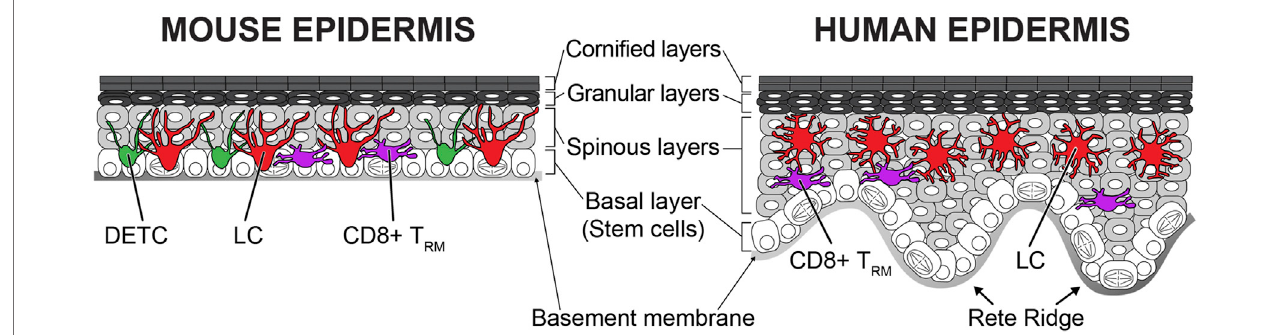
FIGURE1| Structure andcellularcomponentsofmouseandhumanepidermis.Highlyorganized epithelialcellscomposed ofstrati fi edepitheliumintheepidermis. The bottommost basal layer cells are attached to the basement membrane. Epithelial stem cells are in the basal layer and differentiate upward. Both mouse and human epidermishavefourdifferentlayers(basal,spinous,granular,andcorni fi edlayers).Thehumanepidermisismuchthickerthanthemouseepidermisandhasanundulated rete ridge structure. Both undifferentiated and differentiated epithelial cells form cellular junctions to build the solid strati fi ed structure. The strati fi ed epithelium acts asphysicalbarriersfromouterenvironment.Therearetissue-residentimmunecellswithintheepidermis.Langerhanscells(LCs),dendriticepidermalTcells(DETCs),and CD8 + tissue-resident memory T cells (T RM s) exist in the mouse epidermis, but humans do not have the DETCs. These immune cells continuously surveil possible infections and perform immunological barrier